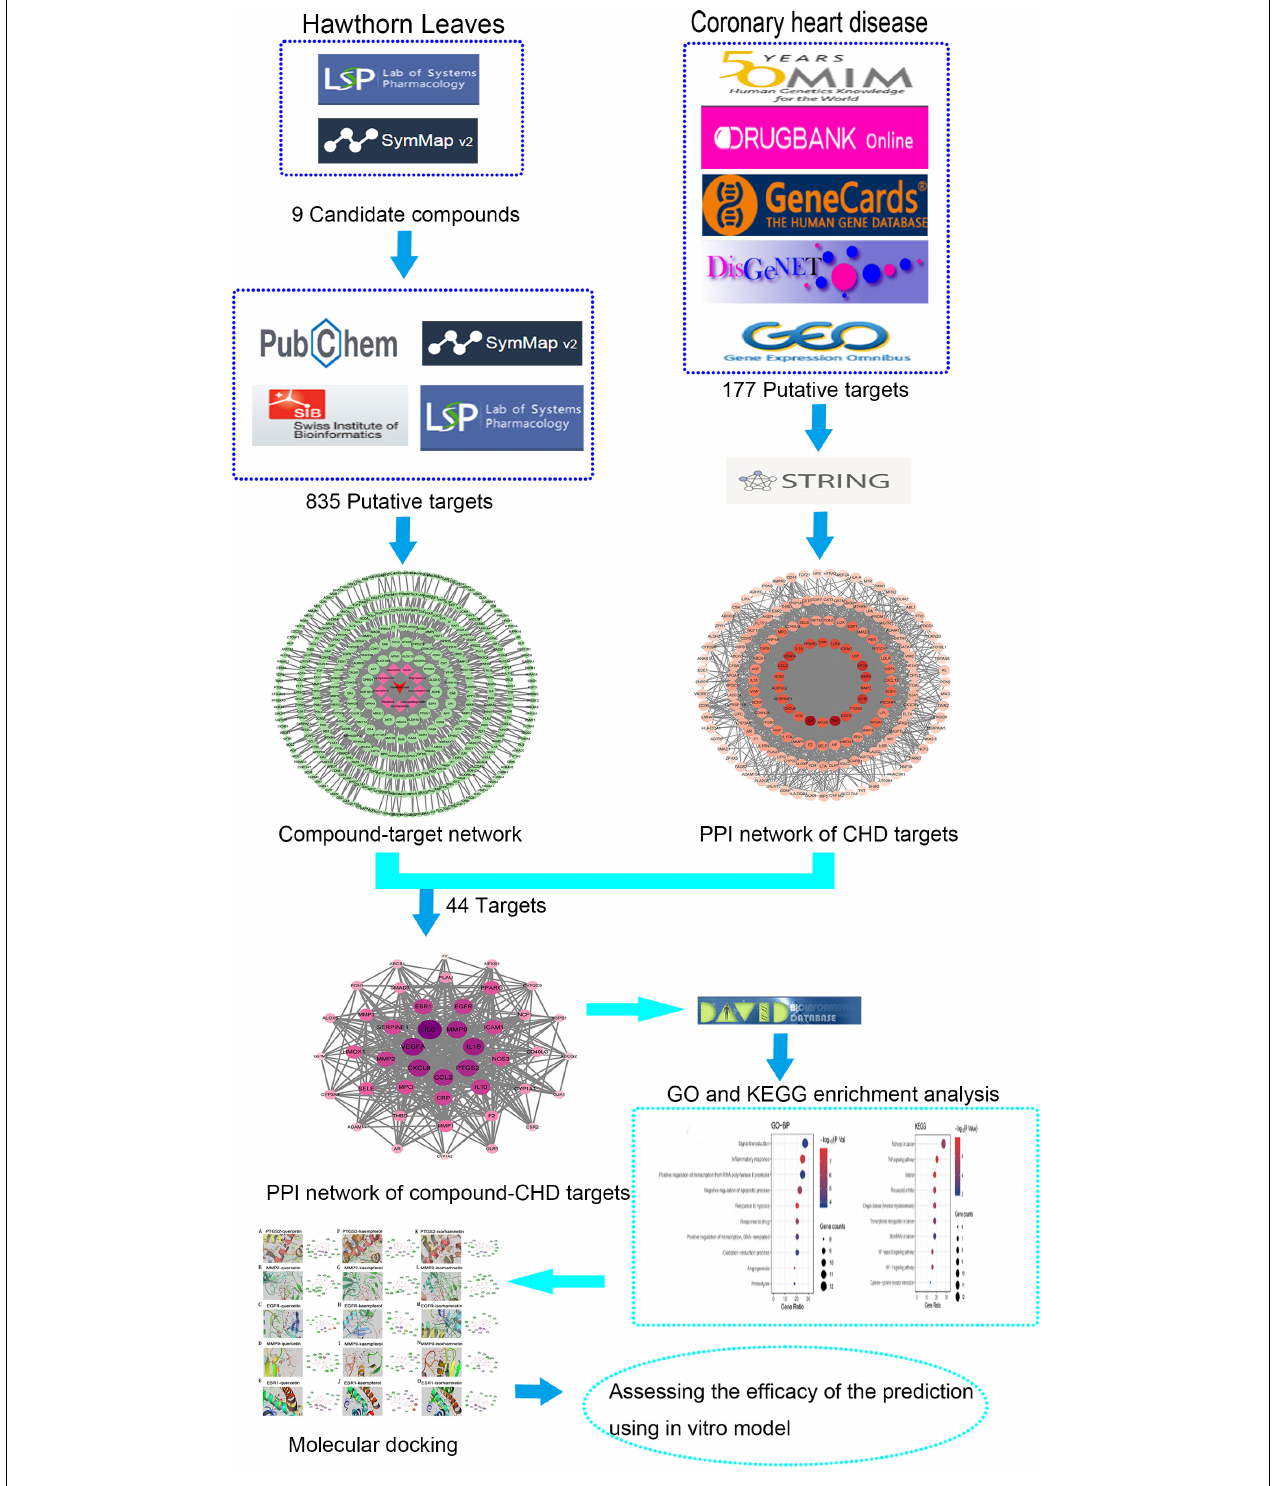
FIGURE 1 | Flow diagram of investigating the mechanism of hawthorn leaves in treatment of CHD.